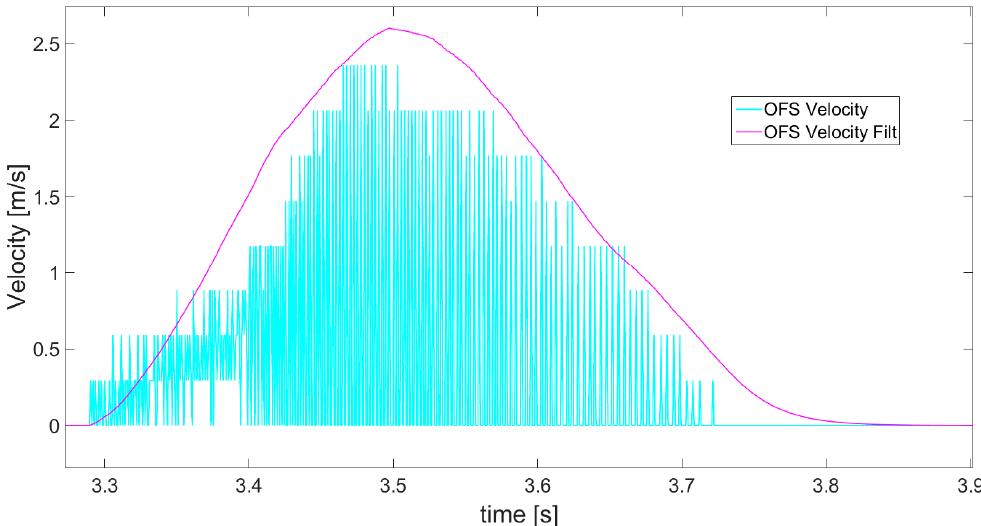
Figure 14. Magnification of part of Figure 13 presenting the noisy OFS readings of velocity (cyan) and magenta line of velocity creating an envelope after applying alpha-beta filter.